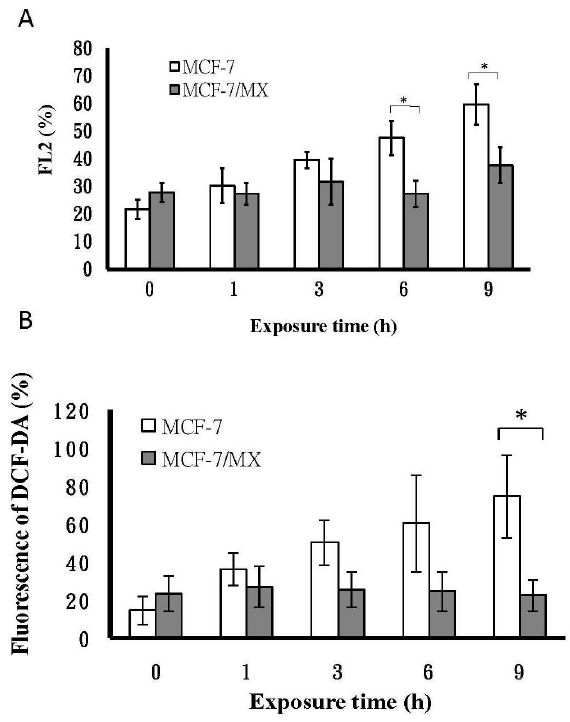
Figure 3. Mitochondrial function of MCF-7 and MCF-7/MX under hypoxia. ( A ) Mitochondrial membrane potential was determined by reduction of JC-1 fluorescence in MCF-7 and MCF-7/MX cells under hypoxia (at 1% oxygen). Data are given as percentage; ( B ) ROS generation in MCF-7 and MCF/MX cells under hypoxia. MCF-7 cells and MCF-7/MX cells were cultured under 1% oxygen tension in a multi-gas incubator (on day 2 with hypoxic periods of 1, 3, 6, and 9 h). An oxygen electrode was used to confirm and calibrate hypoxia treatment. After hypoxia treatment, the production of ROS was measured by using the oxidation-sensitive fluorescent dye DCF-DA. DCF fluorescence intensity was determined on the basis of mean fluorescence of 10,000 cells with FACScan. Values represent mean ± SE of n = 3 independent experiments ( n = 3). * p < 0.05 (MCF-7 vs . MCF-7/MX).